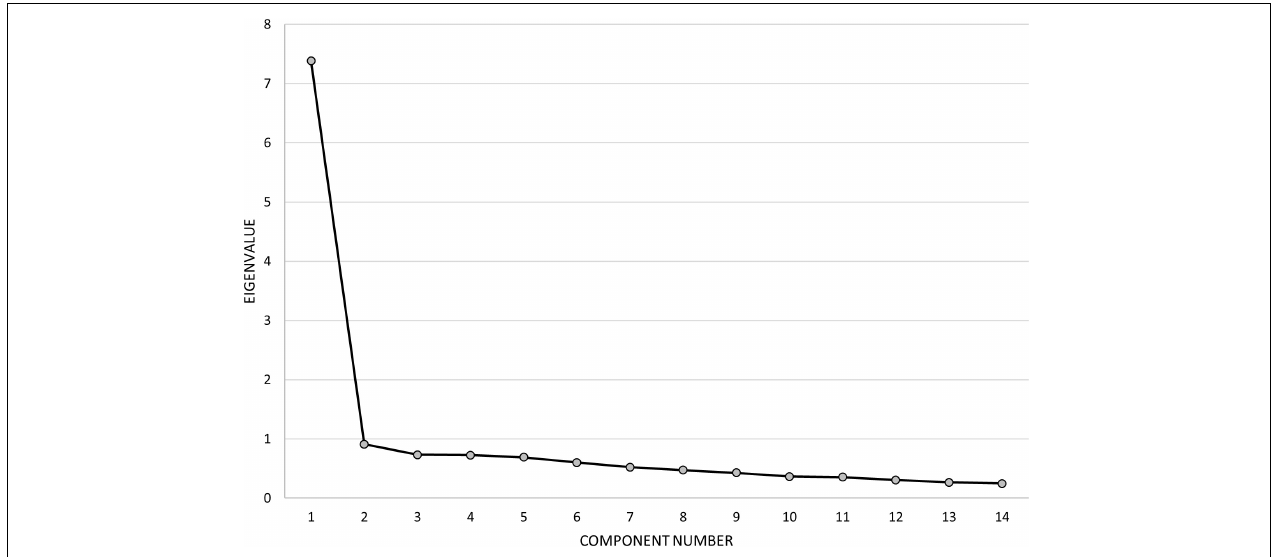
FIGURE 7 | Scree plot summarizing eigenvalues obtained from the principal component analysis. A clear one-component solution is supported by the rapid drop in eigenvalues after the first